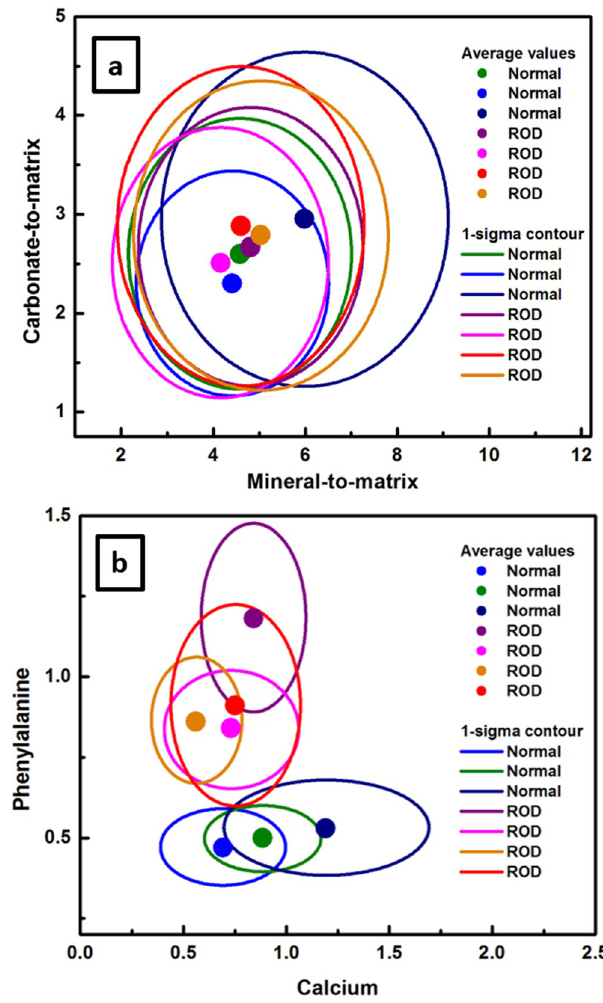
Figure 4. Statistical representation using 1-sigma ellipsoids of: ( a ) the carbonate-to-matrix biomarker versus the mineral-to-matrix biomarker, and ( b ) the phenylalanine content versus that of calcium. The solid circle defines the average over 22,500 spectra for each biomarker. For consistency, an identical color-code was again used.